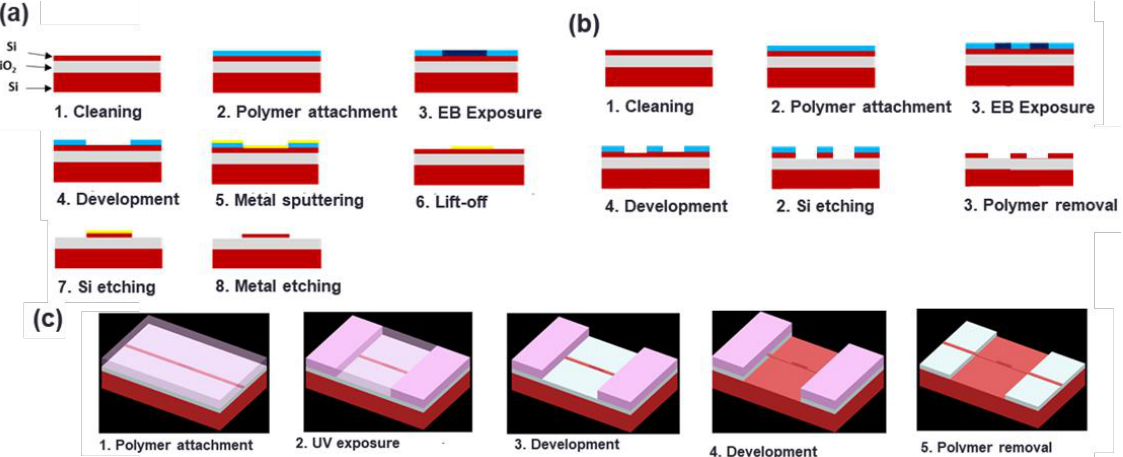
Figure 8. Sensor fabrication procedure steps ( a ) Lift-off method for WG formation, ( b ) inverse exposure method for WG formation, and ( c ) sensing region suspension.